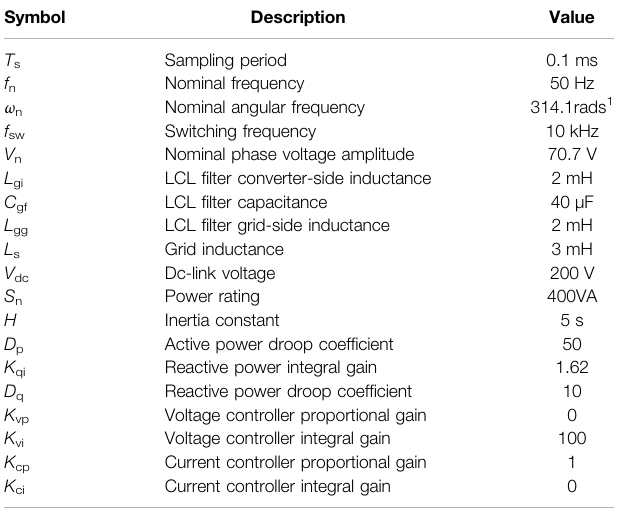
Figure 5A veri fi es the sensitivity analysis result of Figures 5B .